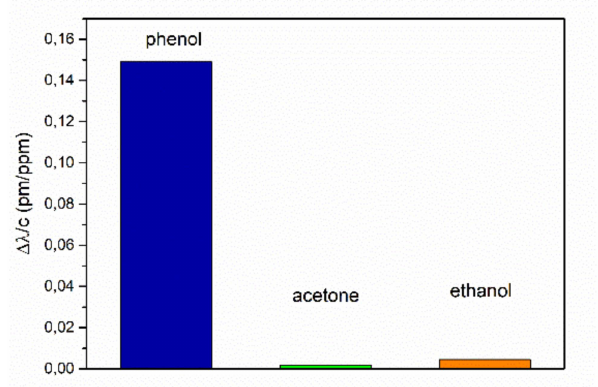
Figure 10. Shift of the resonant wavelength for 1 ppb concentration of organic